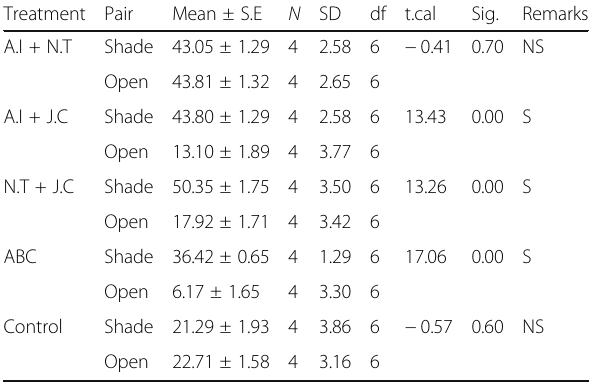
Table 2 Student t test comparing weight loss in extract-treated wood exposed to subterranean termite under shade and in the open field